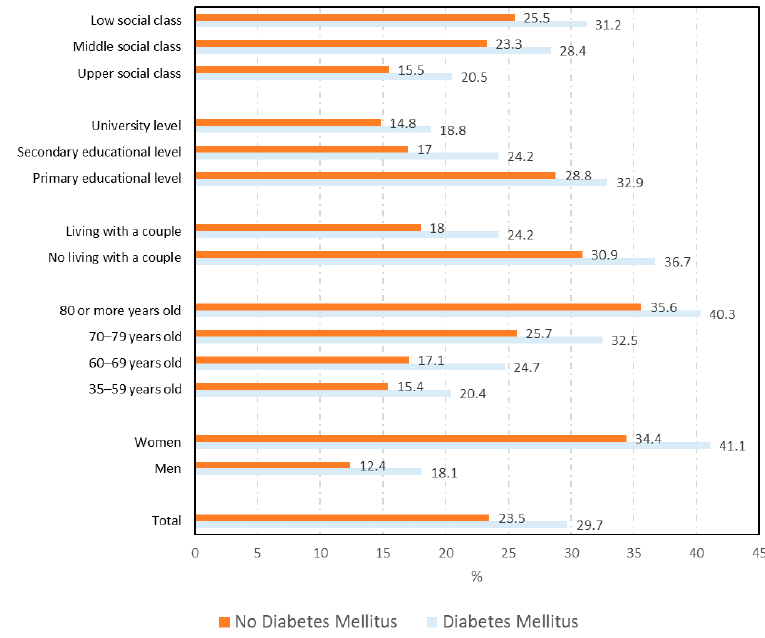
Figure 3. Prevalence of consumption of psychiatric medications according to sociodemographic variables among diabetes mellitus cases and controls.